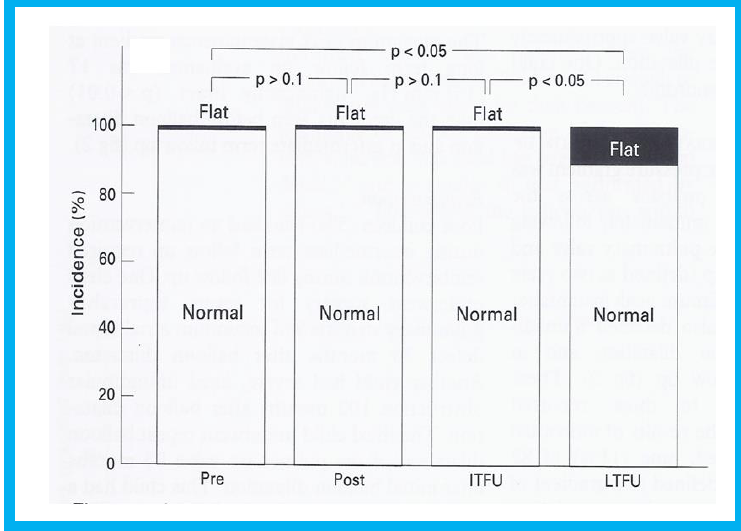
Figure 16. Bar graph showing the prevalence of inter-ventricular septal motion prior to (Pre) and one day after (Post) balloon pulmonary valvuloplasty and at intermediate-term (ITFU) and long-term (LTFU) follow-up: Note significant increase ( p < 0.05) in the incidence of flat septal motion at LTFU. No patient was observed to have paradoxical septal motion. Reproduced from Rao P.S., et al. [16].